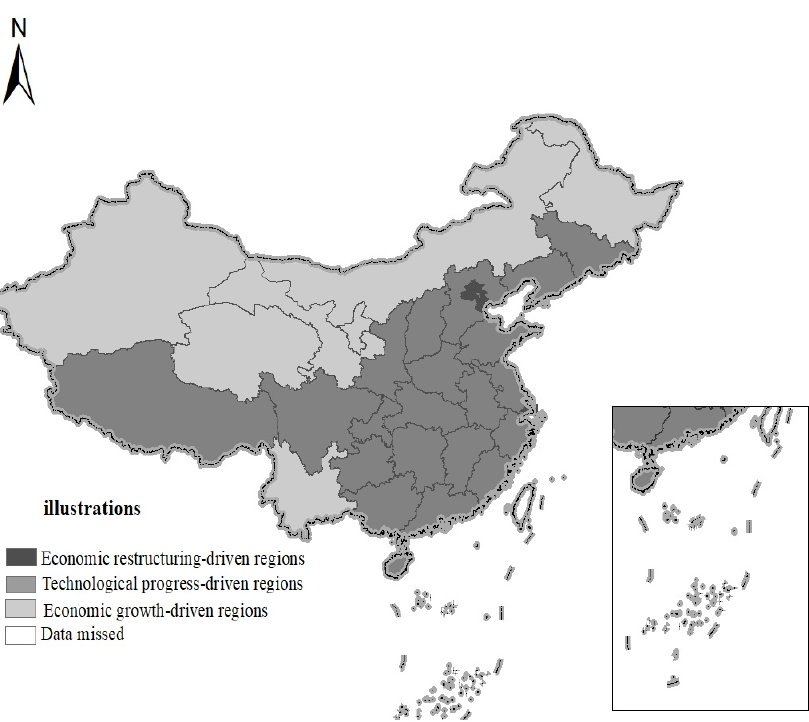
Figure 4. Regions with different types of drivers. Note: This map is based on the standard map downloaded from the standard map service website of the National Bureau of Surveying, Mapping, and Geographic Information with the approval number GS (2016)2556. The base map has not been modified.